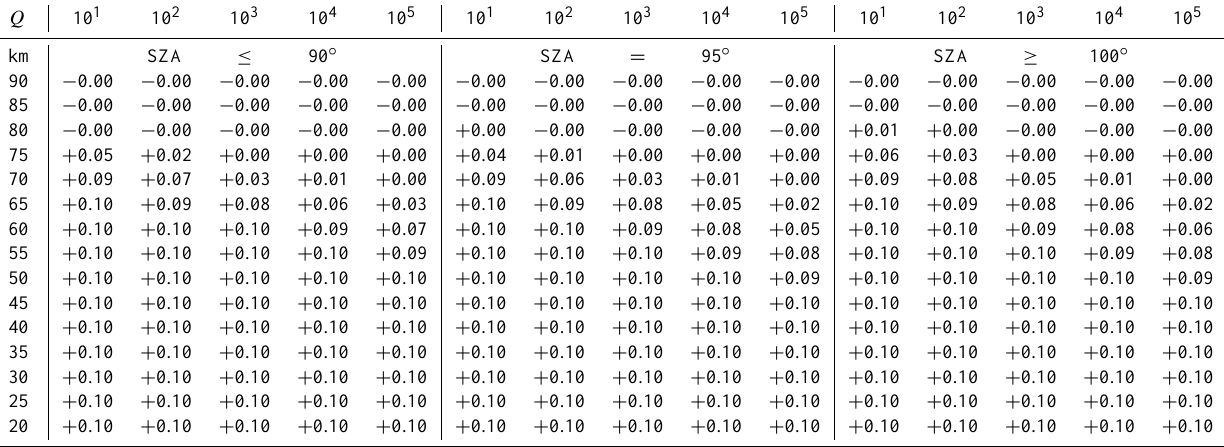
/Q for January NH. 2